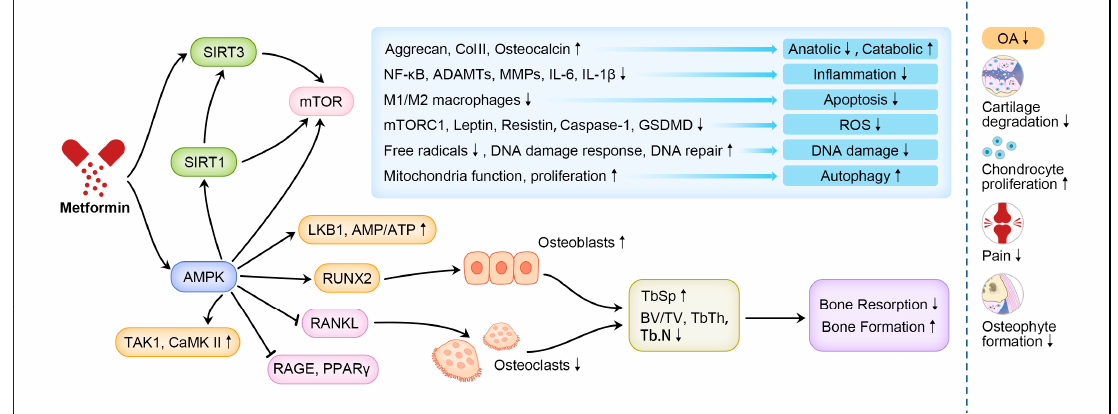
Figure 2. The mechanism of metformin in preventing OA. Note: ↑ means up-regulation; ↓ means down-regulation. Table 1. Roles of metformin in OA.